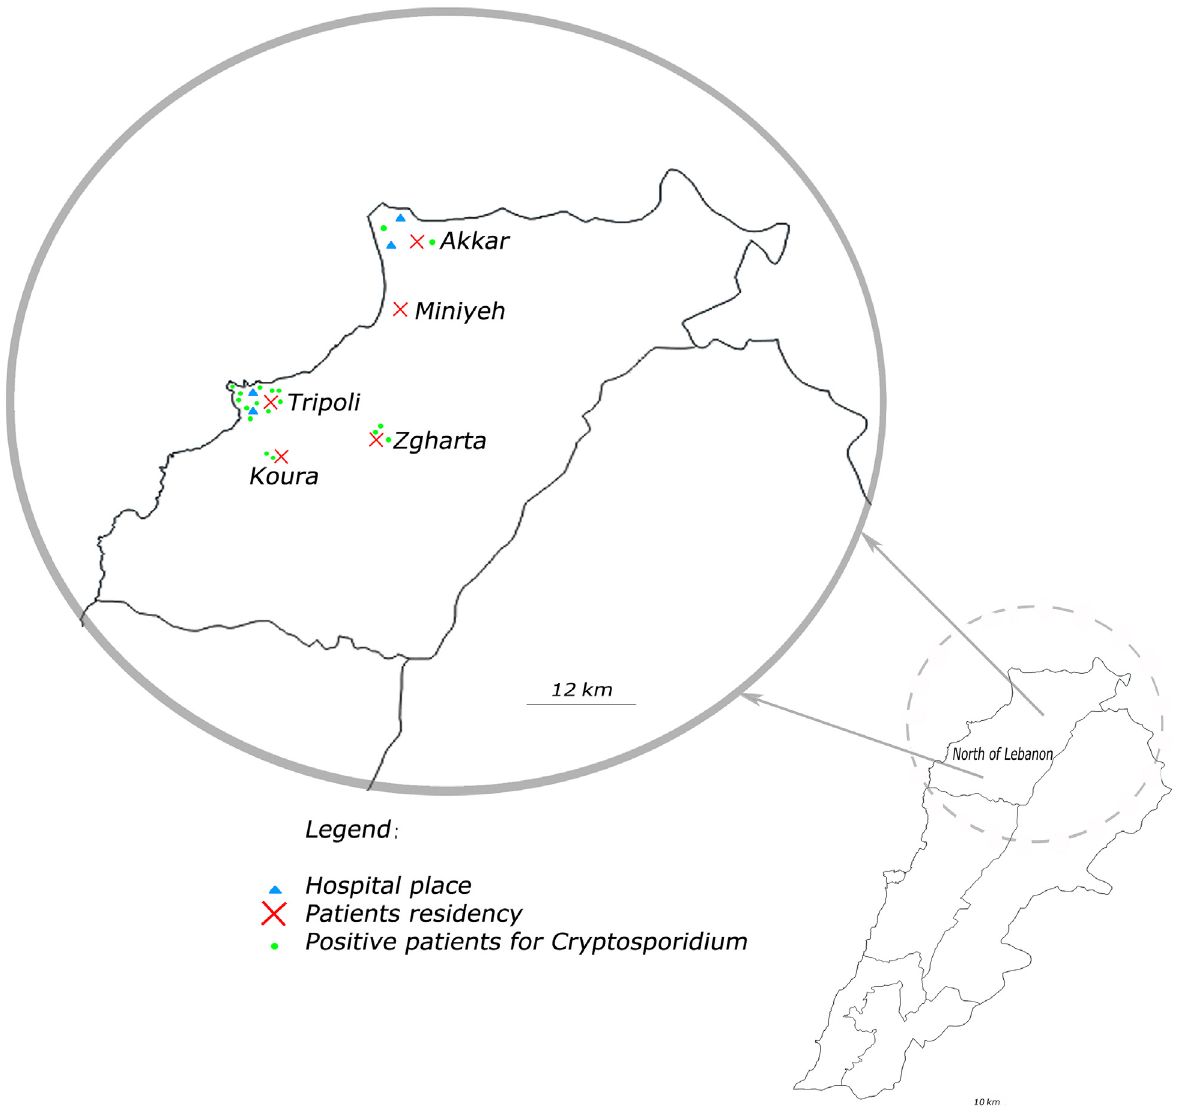
Fig 1. Geographic distribution of cryptosporidiosis cases identified in this study in Lebanon.